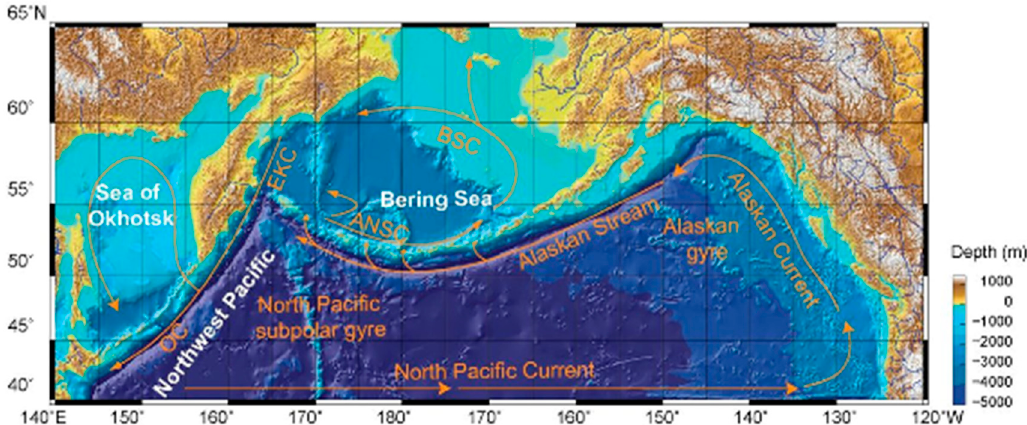
Figure 1. Bathymetric chart of the study region with major oceanic surface currents (orange arrows) from Max et al. [3]. OC = Oyashio Current; EKC = East Kamchatka Current; ANSC = Aleutian North Slope Current; BSC = Bering Slope Current.